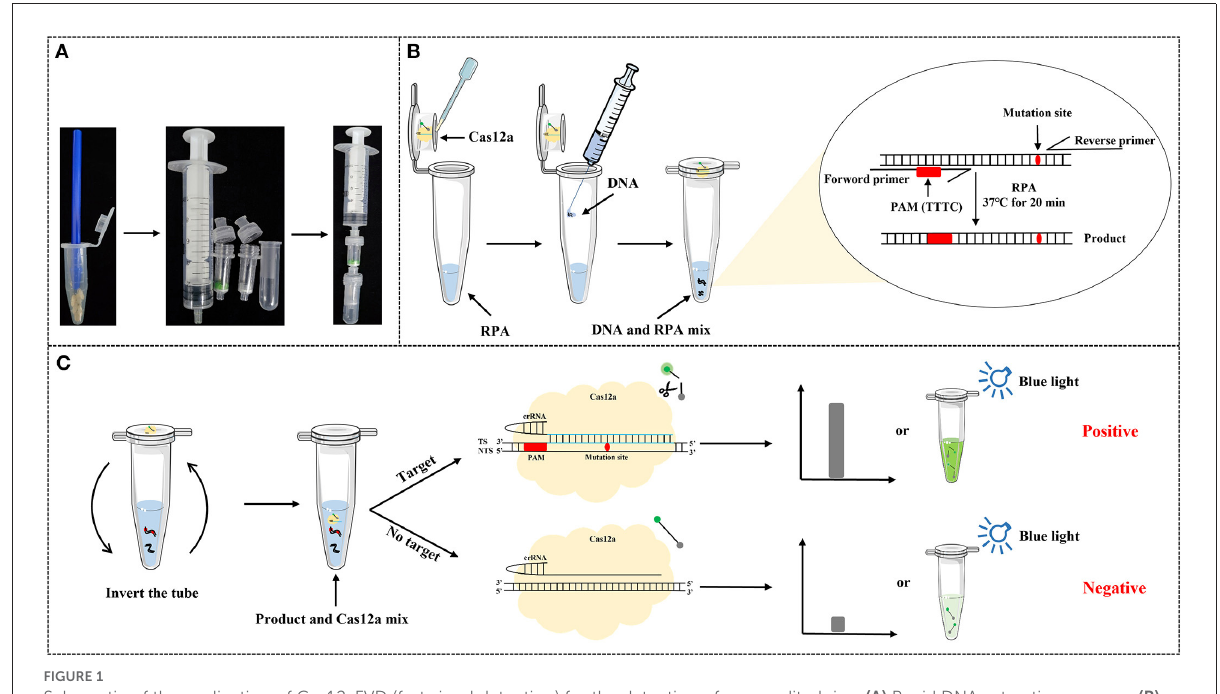
FIGURE1 Schematic of the application of Cas12aFVD (fast visual detection) for the detection of gene-edited rice. (A) Rapid DNA extraction process. (B) Insertion of the protospacer adjacent motif (PAM) at an appropriate site through recombinase polymerase amplification (RPA). (C) After amplification, invert the tube to mix with Cas12a reagent for an additional 15min. The fluorescence signals can be observed by the 7500 Real-Time PCR System (Thermo Fisher Scientific, USA) or by the naked eye under blue light